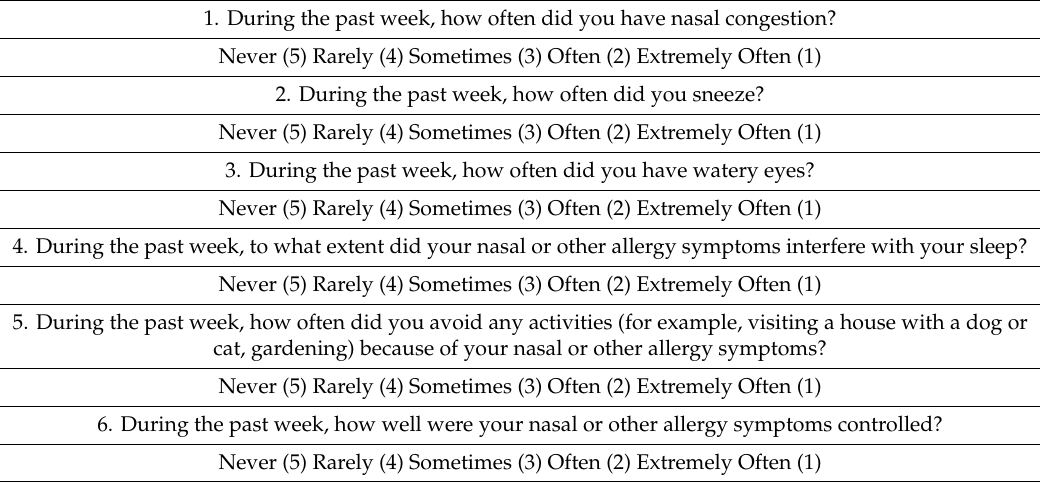
Table 3. Rhinitis Control Assessment Test (RCAT) questionnaire *